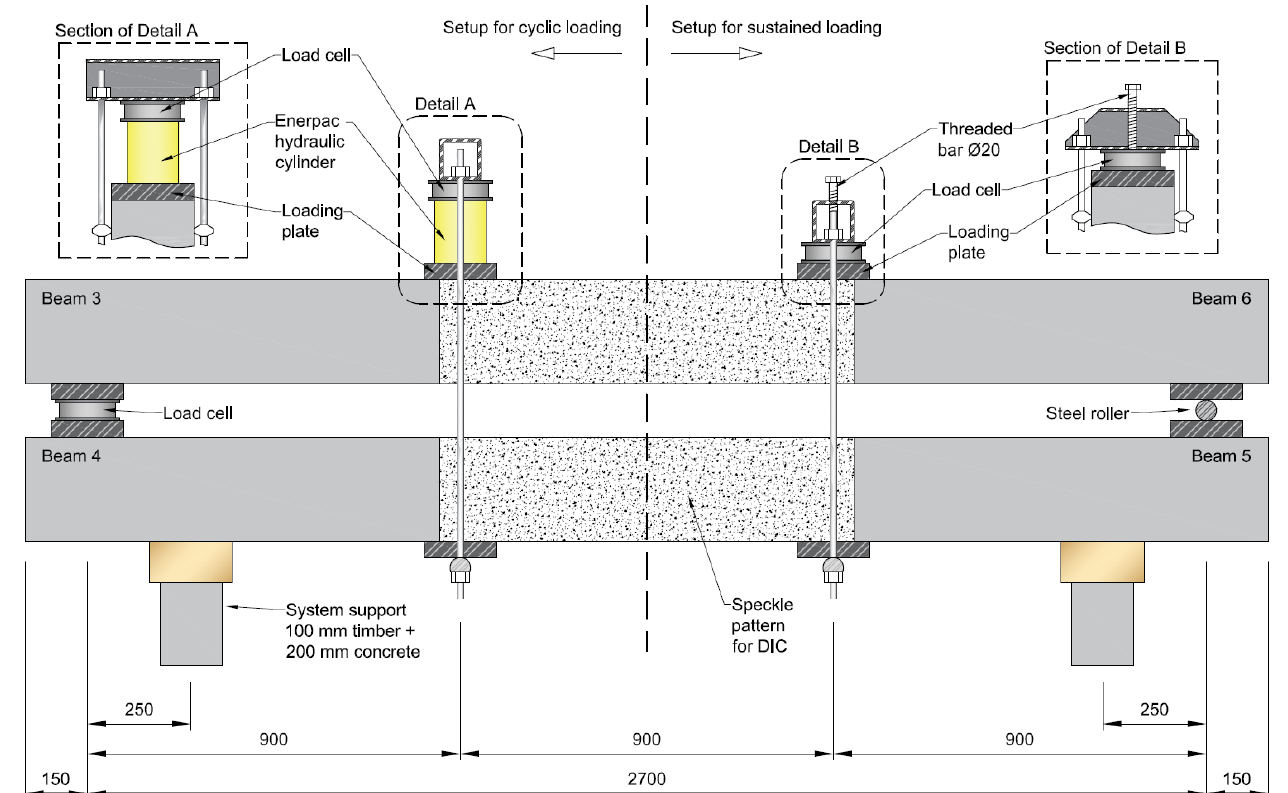
Figure 2. Loading setup for the long-term loading experiments (all measurements in mm). For the group of beams subjected to cyclic loading, a hydraulic cylinder was placed between the clamping device and the loading plate of the top beam, cf. Detail A in Figure 2; the imposed deformation on the group of beams subjected to sustained deflection was achieved by tightening a threaded bolt screwed into the clamping device, cf. Detail B in Figure 2. Two load cells were provisioned at the loading points over the top beam and one more between the support plates at one of the ends in order to ensure a symmetric load distribution. The load of the Enerpac hydraulic cylinder was automatically controlled using a close-loop feedback control system retrofitted with the measurement of the load-cells. The definition of the loading procedure for the cyclically loaded beams in the time domain was performed according to a squared wave signal where both the amplitude and the duration of the pulses were randomly varied within a given interval, as illustrated in Figure 3. A closed-loop feedback system was used to control the load applied by the hydraulic cylinders. The maximum load applied for each cycle varied between 10 and 36 kN (per cylinder) whereas the pulse duration varied between 1 and 6 h. Conversely, both the load and the interval between pulses were kept constant at 6 kN and 1 h, respectively. The beams subjected to sustained deflection were initially loaded to approximately 30 kN (per loading point) and then reloaded after 44 days to compensate the part of the load lost due to creep